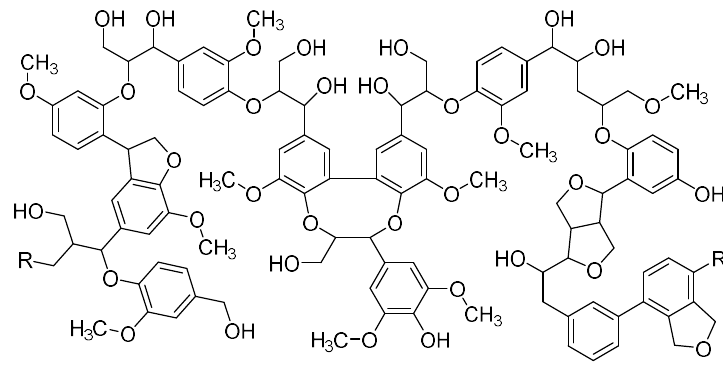
Figure 12. Lignin chemical structure.